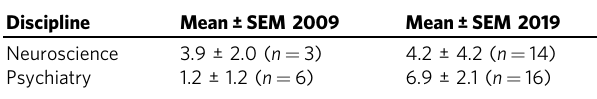
Table 2 The proportional percent of times that male